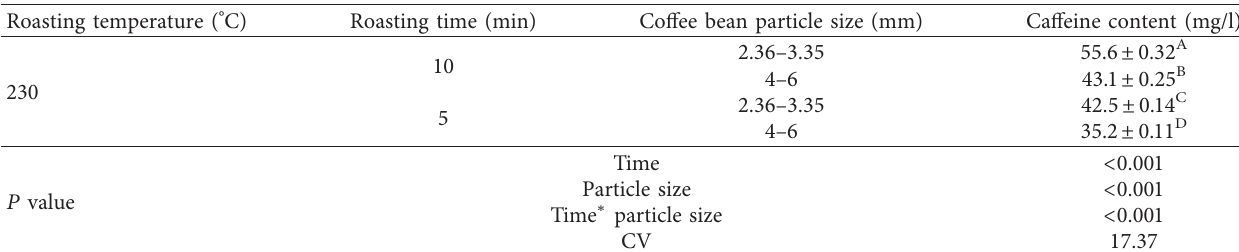
Figure 7: Effect of coffee bean particle size, roasting temperature, and roasting time on the flavor value of the coffee beverage. (a) Roasting temperature at 200 ° C. (b) Roasting temperature at 230 ° C. (c) Roasting temperature at 260 ° Table 2: Effect of coffee roasting temperature at 230 ° C for 10min and 5min time and particle size of 2.36–3.35mm and 4–6 mm on caffeine content.